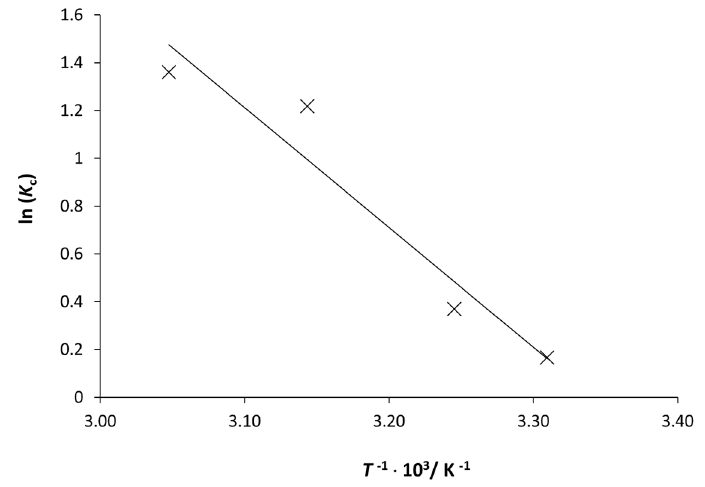
Figure 5. J. H. van’t Hoff plot for adsorption of RB5 dye on activated carbon at pH 0 = 4.00. Table 4. Thermodynamic parameters for the adsorption of RB5 dye on activated carbon for pH 0 =